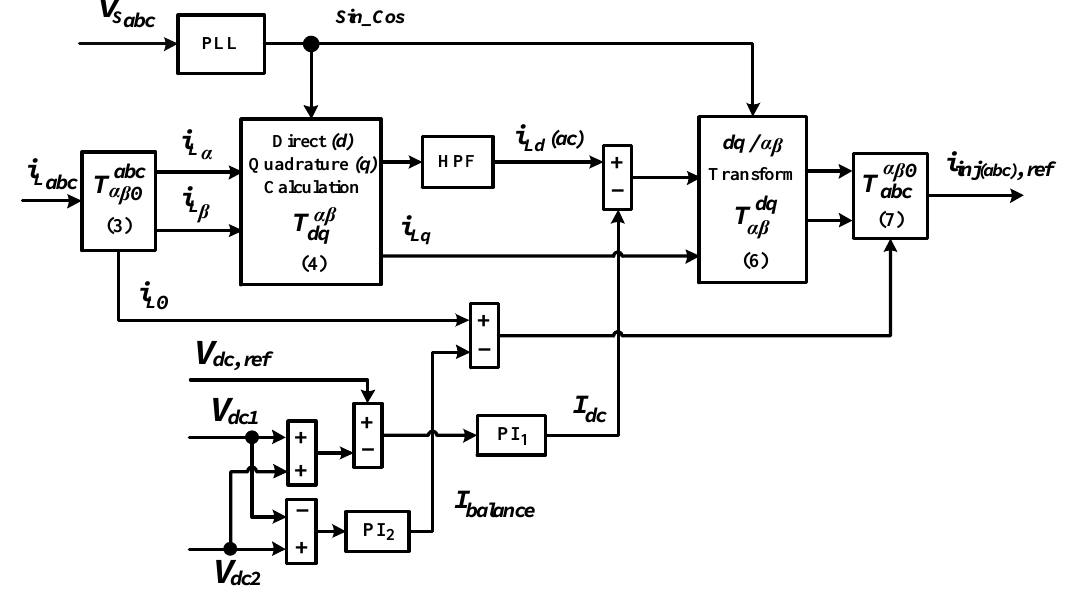
Figure 2. Block diagram showing control structure of standard dq 0 technique [1].